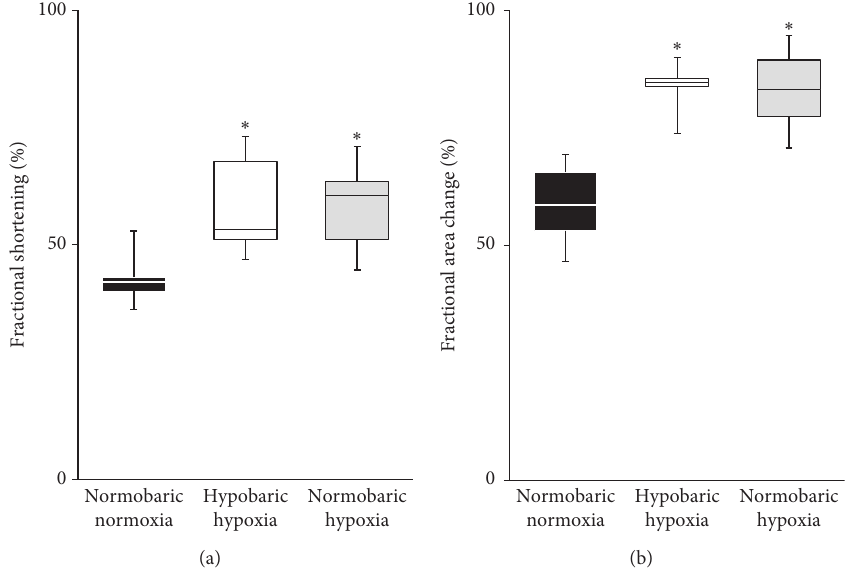
Figure 2: (a) Fractional shortening and (b) fractional area change in three groups. Data are shown as median and interquartile range (IQR), n � 8 rats per group. ∗ p < 0.01 vs. normobaric normoxia group by one-way analysis of variance (ANOVA) followed by Tukey’s post hoc